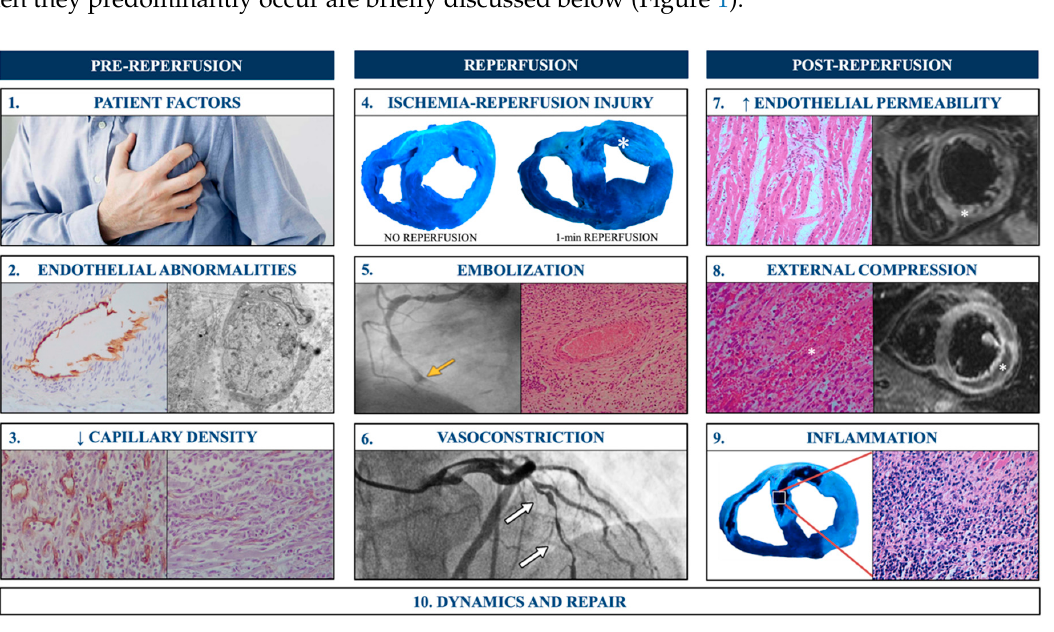
Figure 1. Mechanisms implicated in the pathophysiology of microvascular obstruction (MVO) after myocardial infarction. MVO is a multifactorial phenomenon caused by the interaction of a variety of mechanisms that act predominantly (but not only) at: Pre-reperfusion: ( 1 ) Patient factors. ( 2 ) Endothelial abnormalities. Optic (left) and electronic (right) microscopic views show diffuse microvascular endothelial damage prior to reperfusion. ( 3 ) Decreased capillary density in areas with MVO soon after ischemia onset. Reperfusion: ( 4 ) Ischemia-reperfusion injury. After 90 min ischemia in a swine model, MVO (asterisk) was macroscopically undetectable if the artery remained occluded (left) but was clearly present 1 min after reperfusion (right). ( 5 ) Embolization. Distal migration of thrombotic material (arrow) after primary angioplasty. ( 6 ) Vasoconstriction. Severe vasospasm (arrows) immediately after reperfusion. Post-reperfusion. ( 7 ) Increase in endothelial permeability. Hematoxylin-eosin staining in experimental samples (left) and T2-weighted cardiovascular magnetic resonance in patients (right) display the consequences of increased endothelial permeability; namely, edema (asterisk) and hemorrhaging. ( 8 ) External compression. Severe hemorrhage (asterisk) at the microscopic (left) and macroscopic (right) levels contribute to microvascular compression and MVO. ( 9 ) Inflammation. Massive inflammatory reaction in the core of an area with severe MVO. ( 10 ) Dynamics and repair are crucial to understanding the pathophysiology of MVO. See Section 6 for further details on this